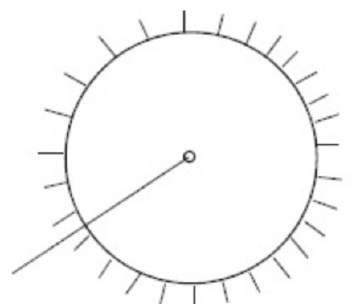
Figure 21 . The ground state of the string state is obtained in the functional integral by propagating during an imaginary time span. If this time span is taken to be long, e.g. go to in(cid:12)nity, the dominantly surviving string state is the ground